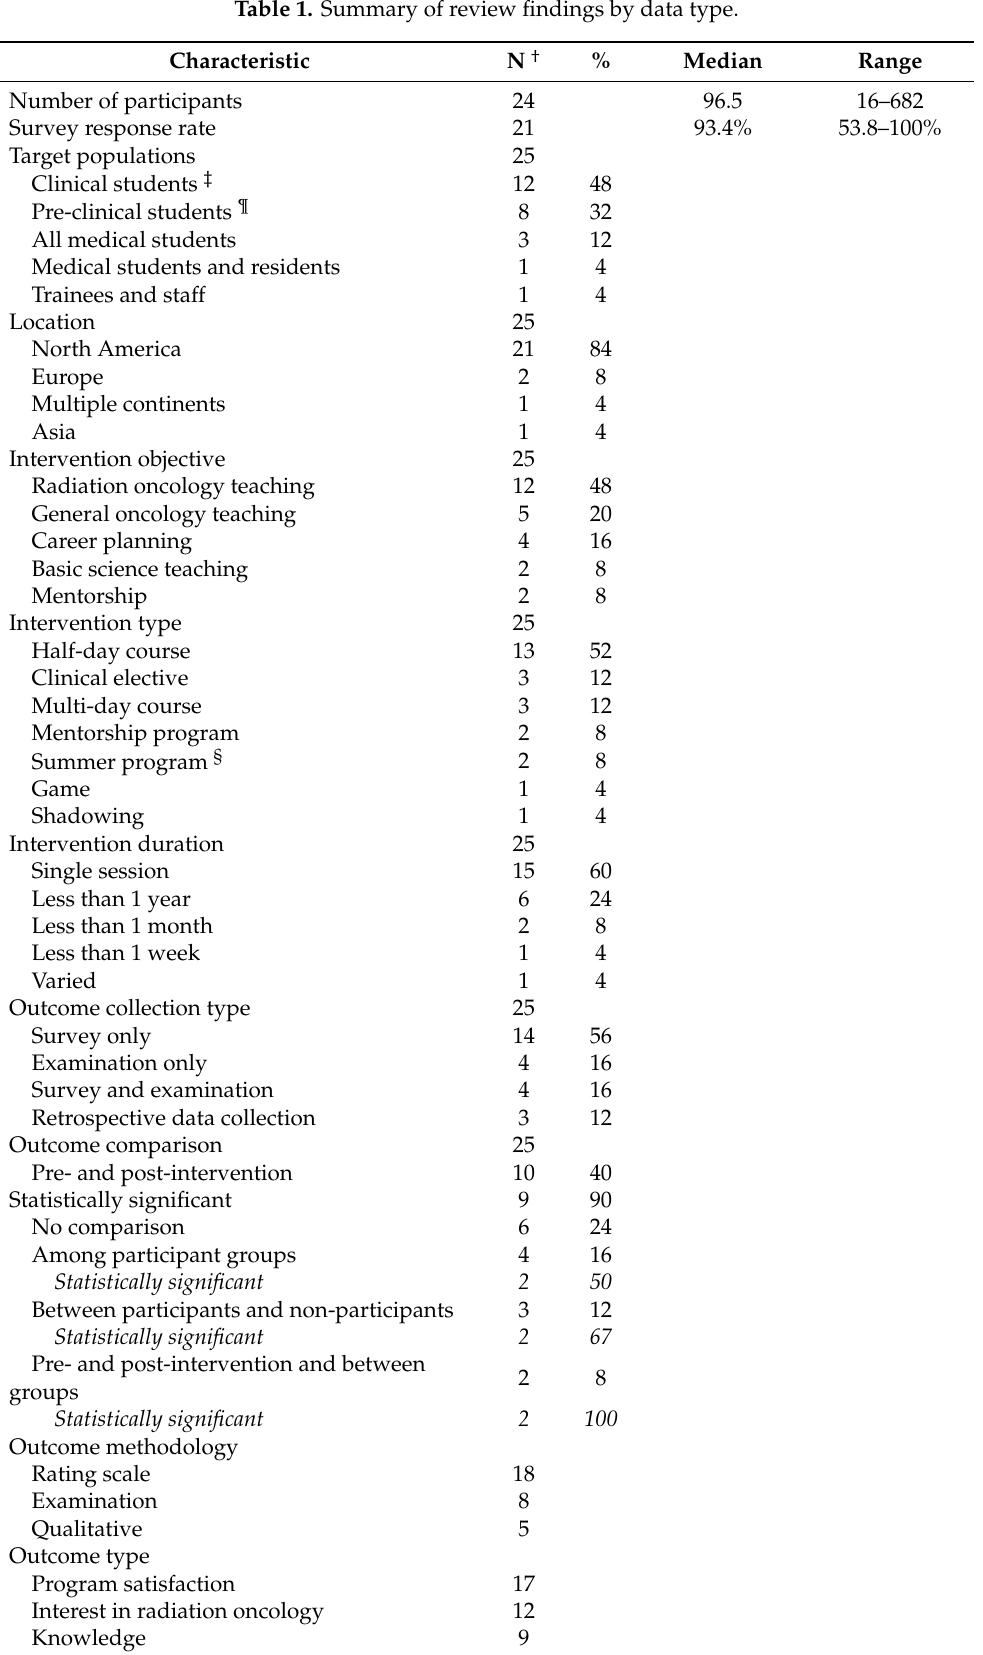
Table 1. Summary of review findings by data